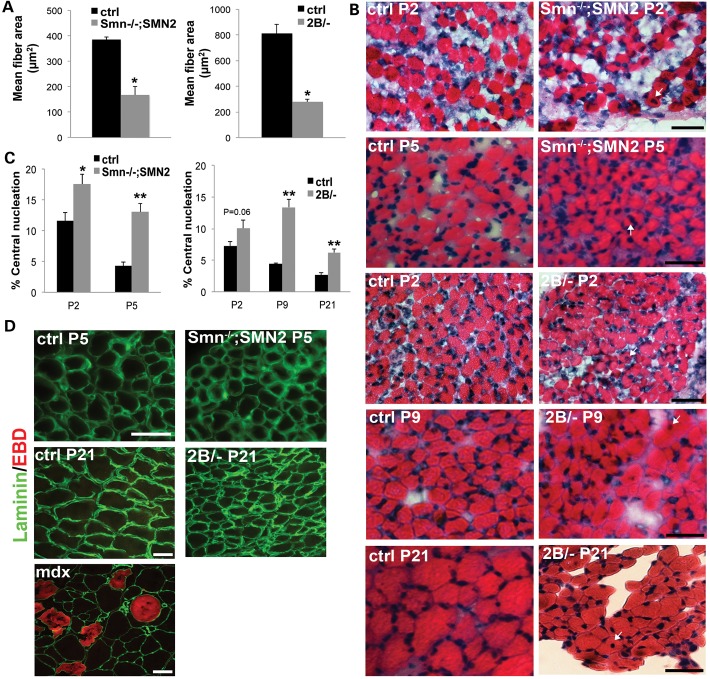
Decreased myofiber size and increased number of immature myofibers in muscle from mouse models of SMA. (A) Cross-sectional area measurements revealed smaller fibers in both mouse models at phenotype stage. Cross-sections of TA muscles from Smn−/−;SMN2 and Smn2B/− mice were taken at P5 and P21 respectively. (B) Representative images of hematoxylin and eosin stained cross-sections from control, prephenotype P2 Smn−/−;SMN2, P2 and P9 Smn2B/− mice, and phenotype stage P5 Smn−/−;SMN2 and P21 Smn2B/− TA muscles. Examples of myofibers with centrally located nuclei are depicted with arrows. Scale bars for P2 samples = 50 μm and scale bars for P5, P9 and P21 samples = 100 μm. (C) Quantification revealed an increased number of centrally located nuclei in both P2 and P5 Smn−/−;SMN2 muscles. No change in the proportion of immature myofibers was observed at P2 in Smn2B/− mice however, an increase in myofibers with centrally localized nuclei was observed in P9 and P21 samples. (D) Evan's blue dye (EBD) is taken up by degenerating fibers and is detected as a red fluorescence signal. Representative images demonstrating the absence of EBD uptake in muscle of control and phenotypic Smn−/−;SMN2 and Smn2B/− mice. TA muscle sections from the mdx muscular dystrophy mouse were used as a positive control for EBD uptake. Scale bar for P5 samples = 100 μm and the scale bar for P21 and mdx samples = 50 μm. N = 3 for all experiments. *, P < 0.05; **, P < 0.01.